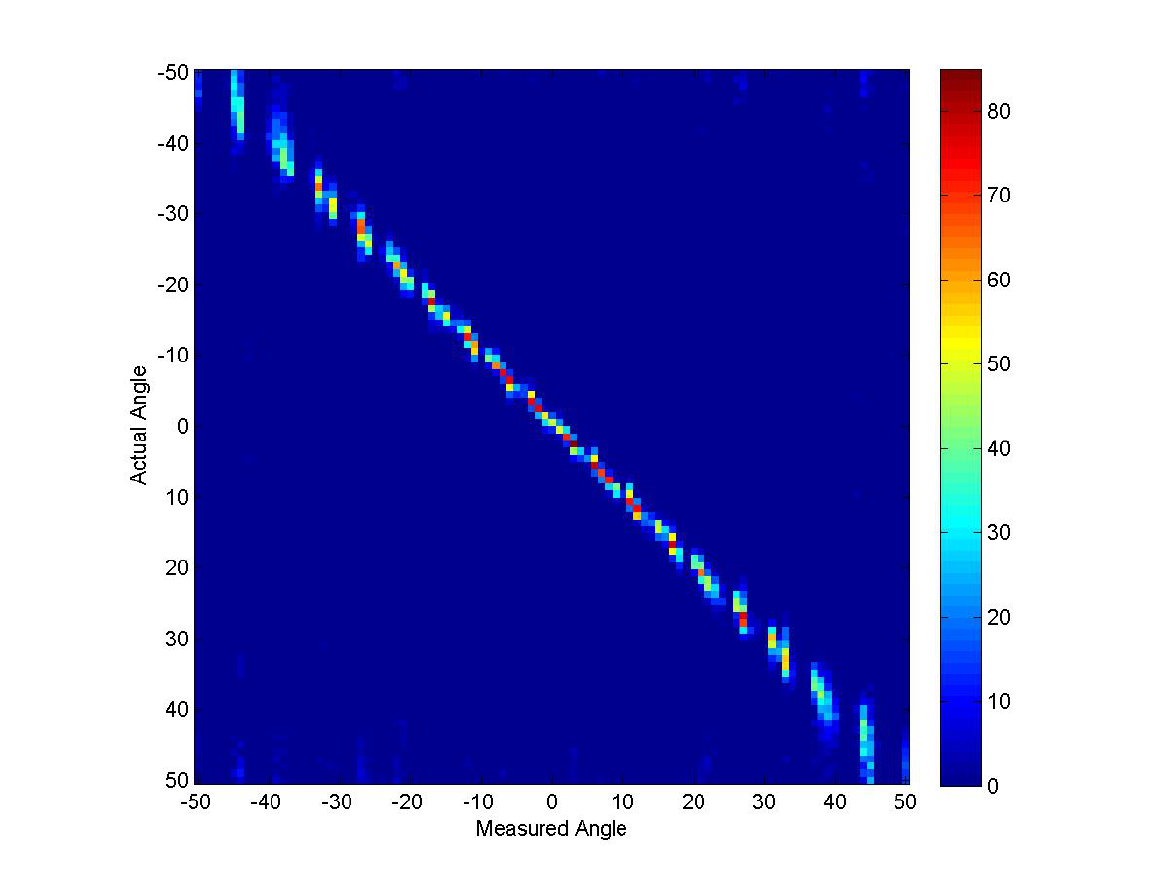
Figure 6. Ambiguity plot for Experiment 1 (no